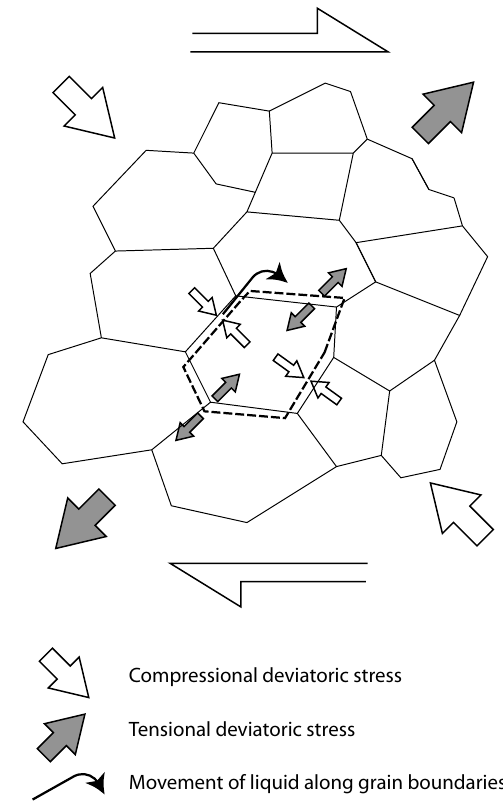
Figure 4. Schematic illustration of grain boundary melting under simple shear. Melting occurs at grain contacts under high stress (compressional deviatoric stress); regelation may occur at grain contacts under low stress (tensional deviatoric stress). Liquid wa- ter moves along grain